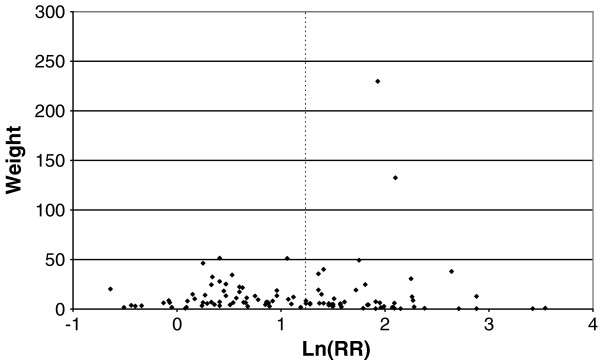
Funnel plot for ever smoking and adeno. Funnel plot of the 107 relative risk estimates for ever smoking and adeno included in the main meta-analysis in Table
5 against their weight (inverse-variance of log RR). The dotted vertical line indicates the fixed-effect meta-analysis estimate.